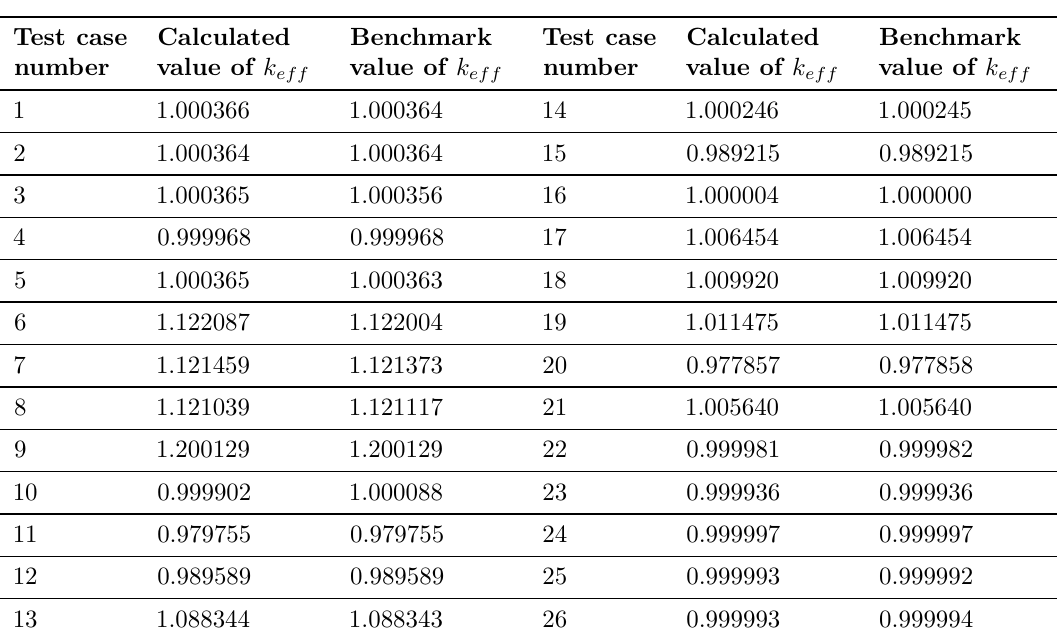
Table 1. Validation of the NESTLE code installation compiled by Gfortran compiler.